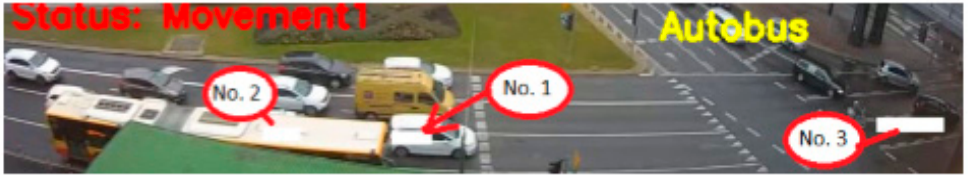
Figure 9. The intersection with marked places used for vehicle detection.